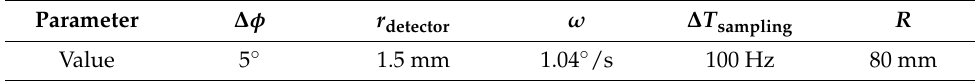
Table 1. Measurement